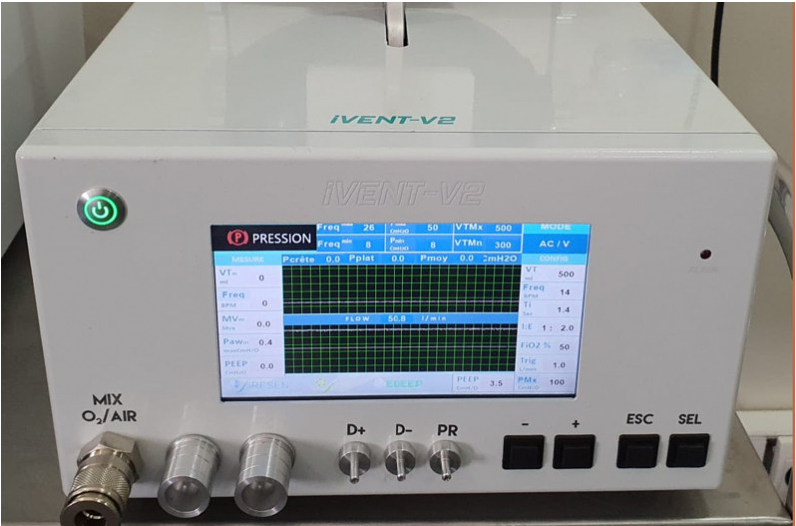
Fig. 5. iVent, developed and adapted by GEP/IRESEN in Morocco from the original Pneuma